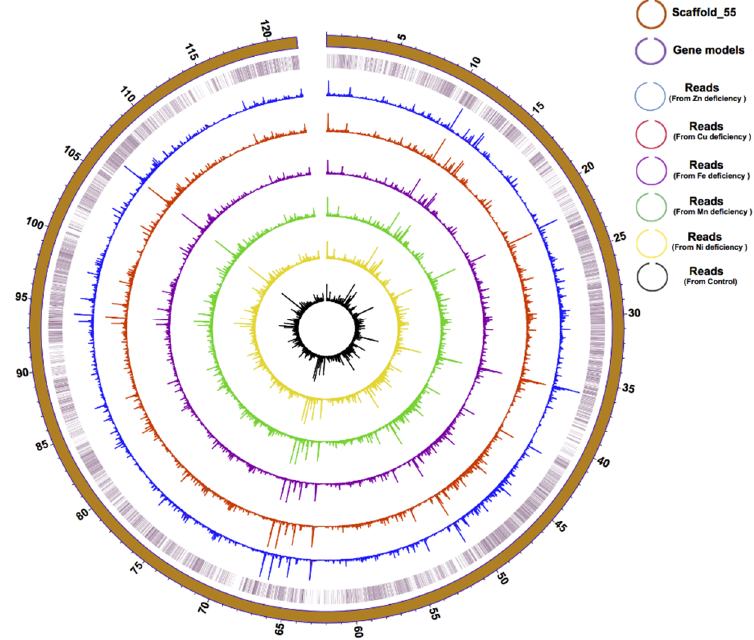
Figure 1. Physical distribution and expression profile of genes in the longest (121 Mbp) Scaffold in F. kawagutii. The circles from the outside to the inside mark scaffold length (in Mbp), gene location, and gene expression (bar height) under Zn-, Cu-, Fe-, Mn-, and Ni-deficient as well as normal conditions.